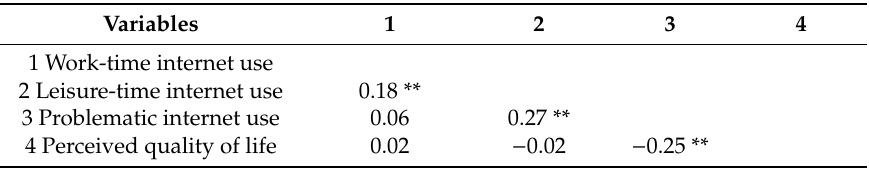
Table 2. Correlation analyses of the main study variables.